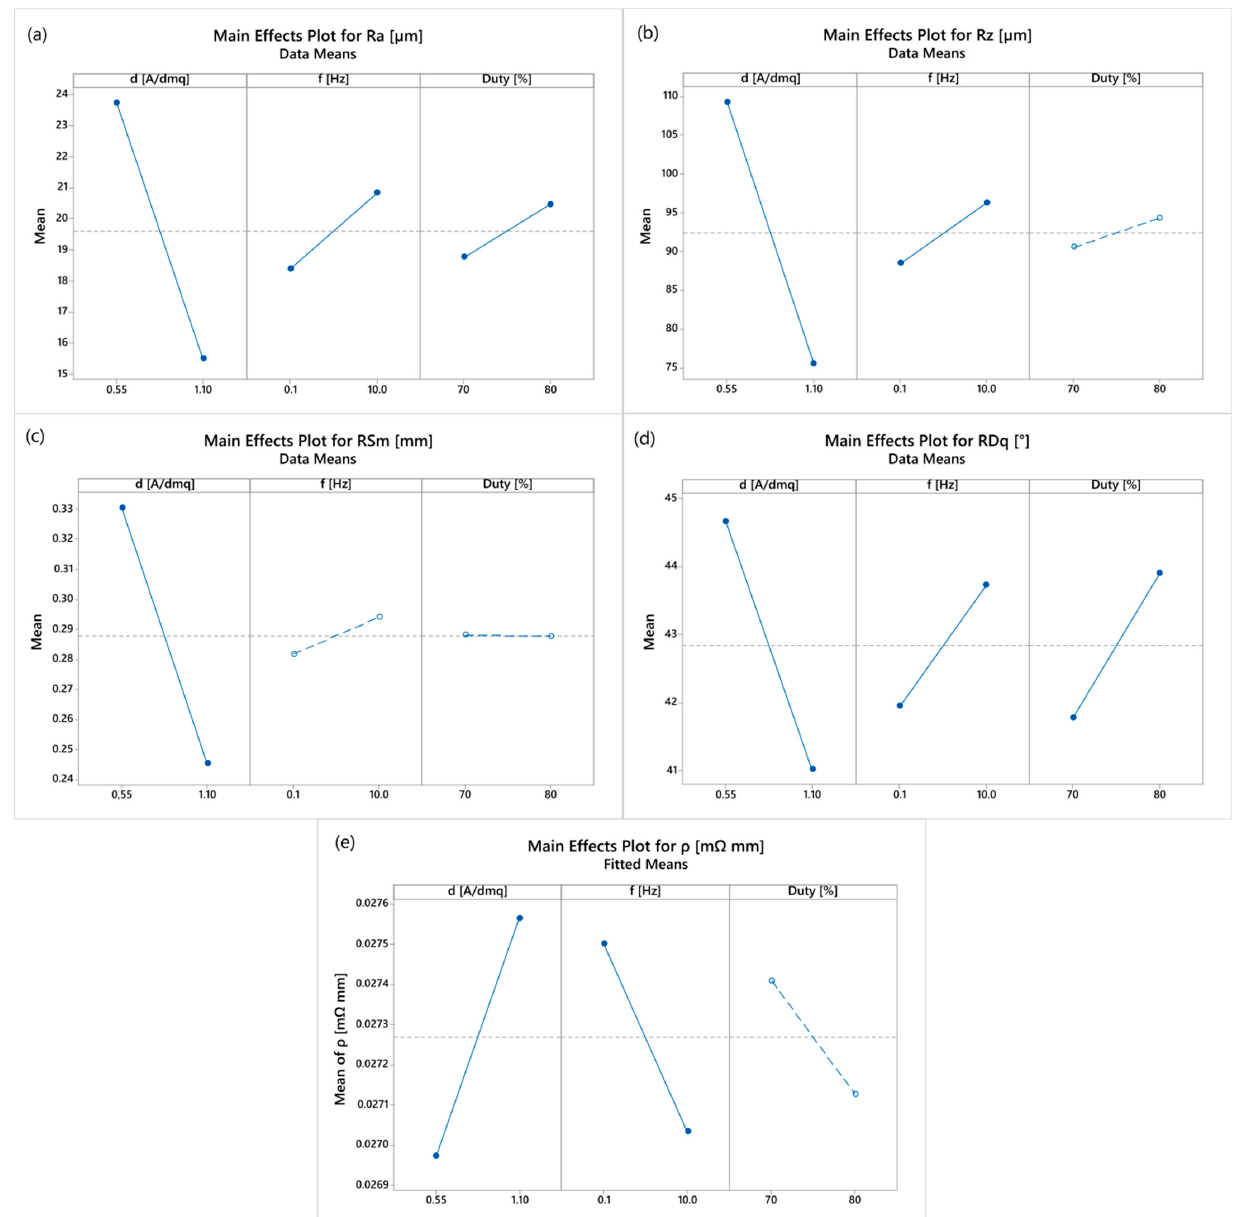
Figure 6. Main effect plots for: ( a ) Ra, ( b ) Rz, ( c ) RSm ( d ) RDq and ( e ) ρ ; not statistically significant plots are in dashed lines.